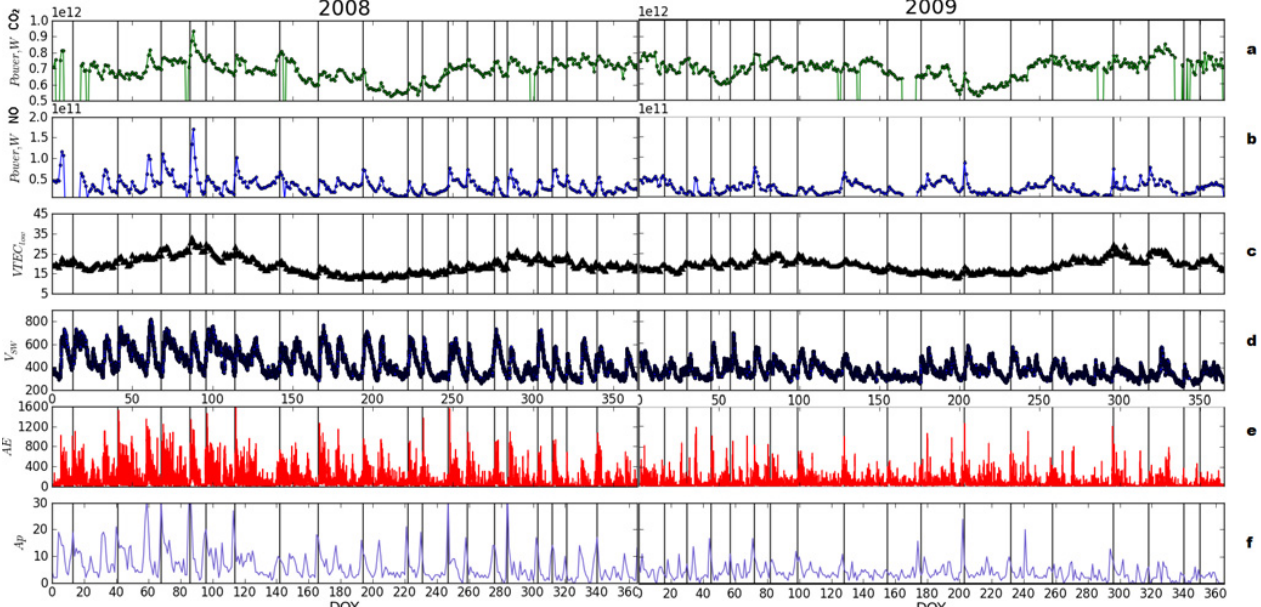
Fig. 2. Selected parameters for 2008–2009: (a) and (b) show global power of infrared CO 2 and NO molecular line emissions; (c) daytime low-latitude VTEC, (d) solar wind speed, (e) AE index and (f) Ap index.